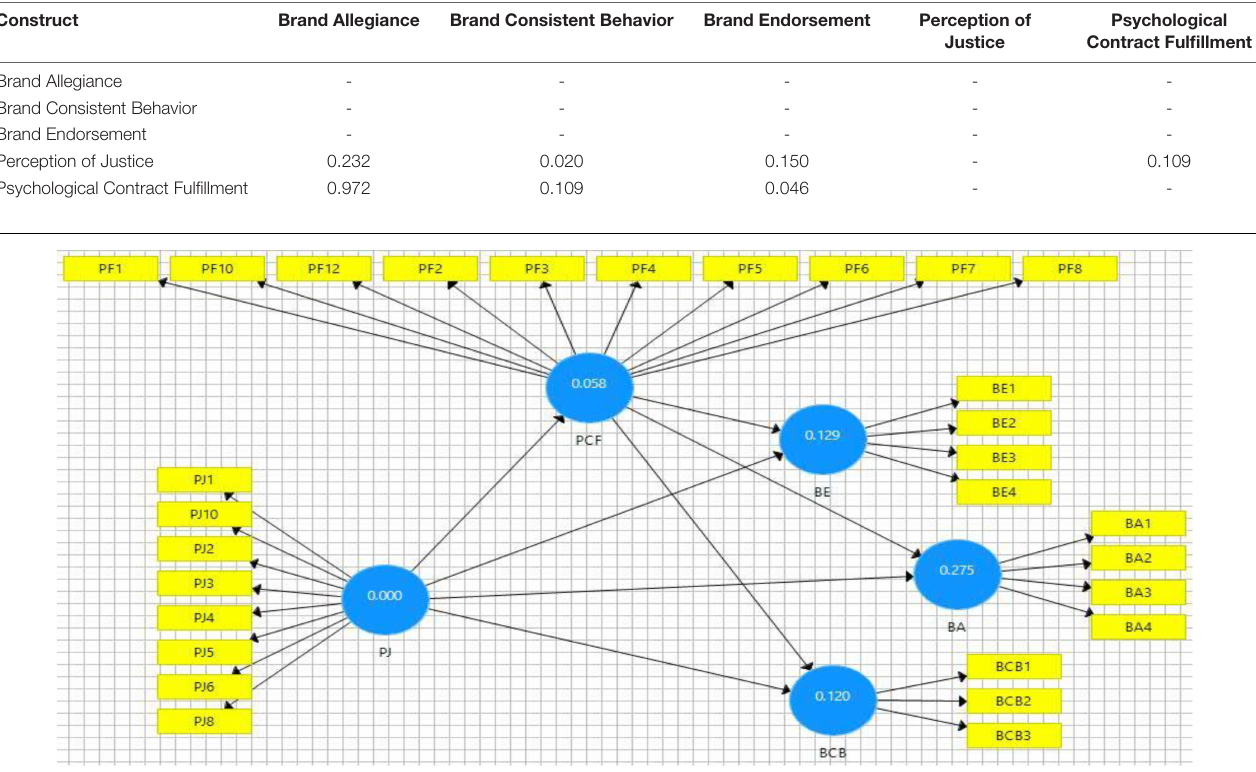
TABLE 6 | Effect size.